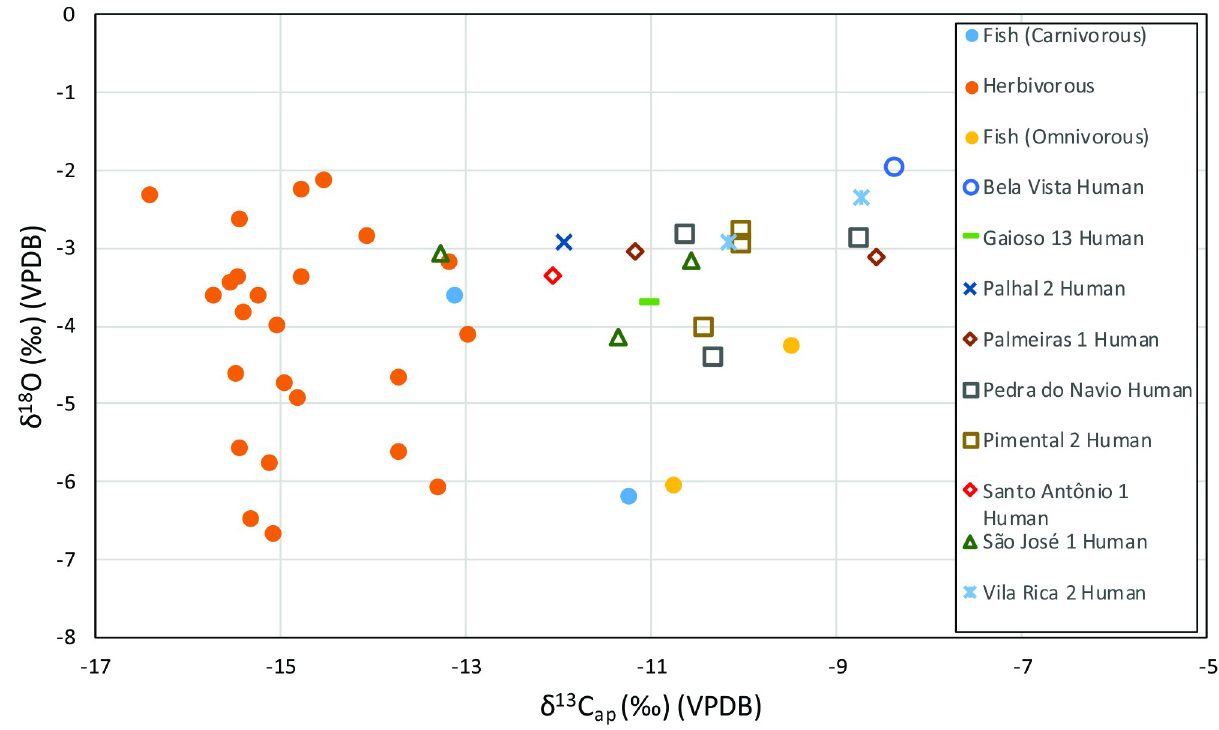
Fig 6. Faunal and human bulk tooth enamel δ 13 C and δ 18 O grouped by diet for VGRX.